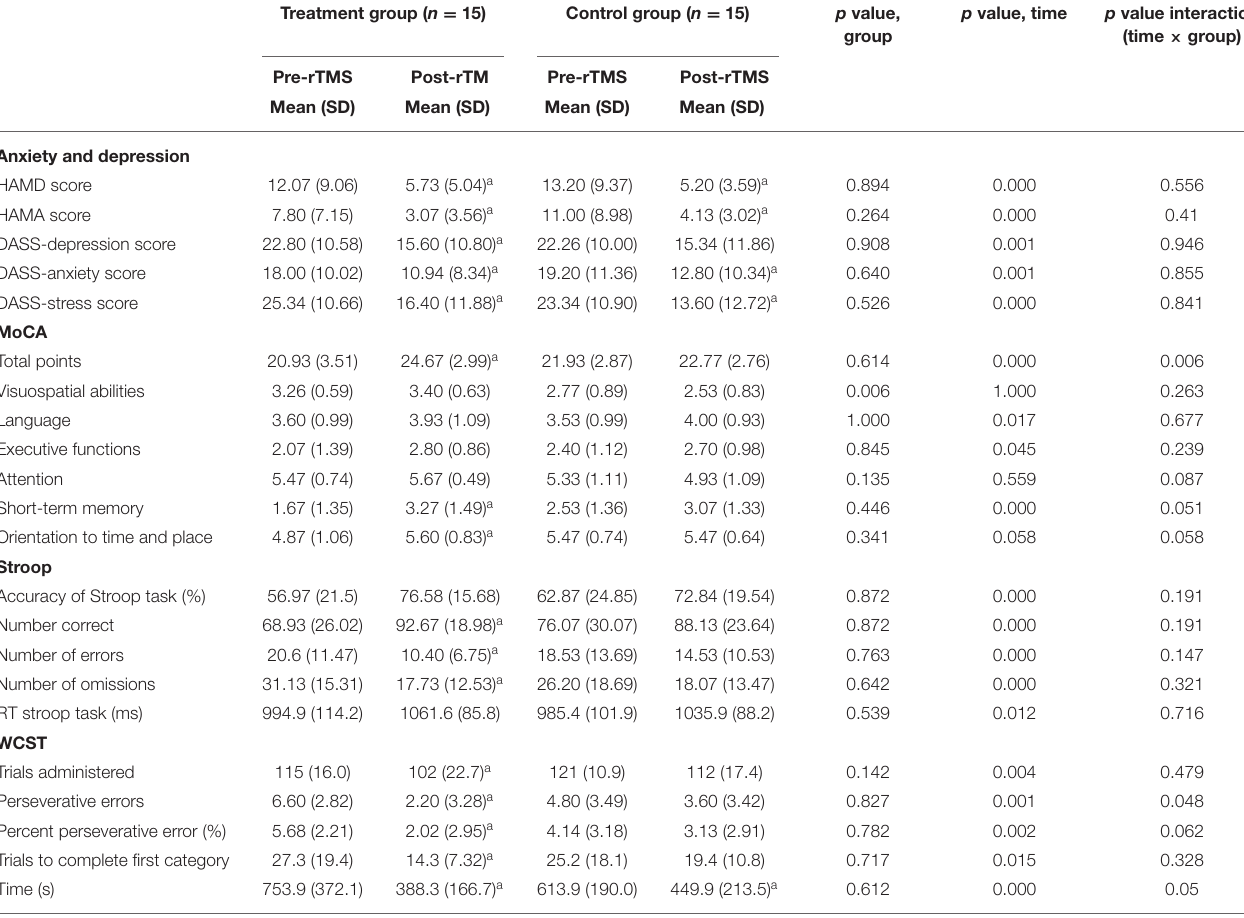
p value, time p value interaction group (time × group)